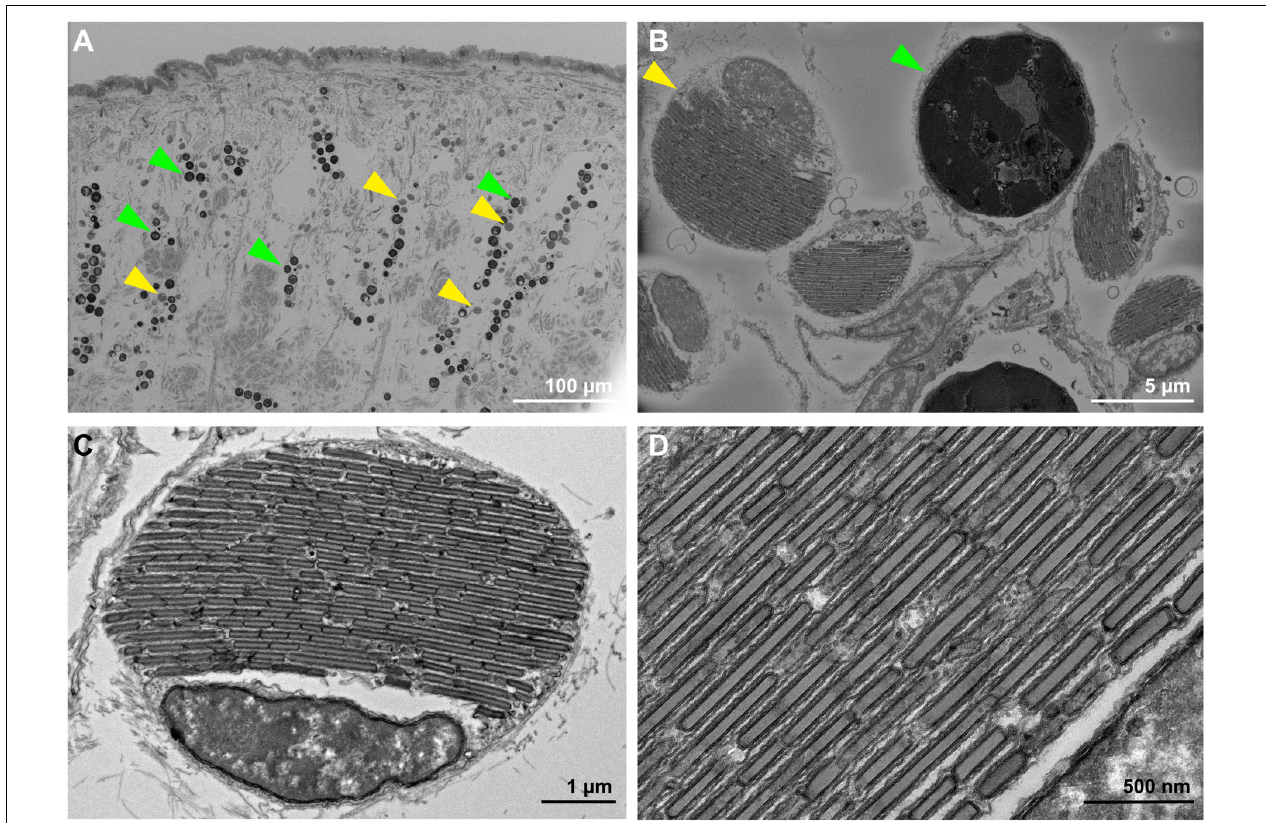
FIGURE 3 | (A) Blockphase SEM image of cross-sectioned T. maxima mantle tissues, from the surface to about 400 µ m deep into the tissue. Symbiotic algae are stacked in pillars and highlighted with green arrows, iridocytes can be found in close proximity and are highlighted with yellow arrows. (B) Magnified view of algal symbionts (green arrow) and iridocytes (yellow arrow). Both have an average diameter of about 8 µ m. (C) TEM image of iridocyte cell with stacked layers of crystalized guanine plates, alternating with cytoplasm sheets. (D) TEM image of magnified view on Iridocyte cell, showing crystalized guanine plates.